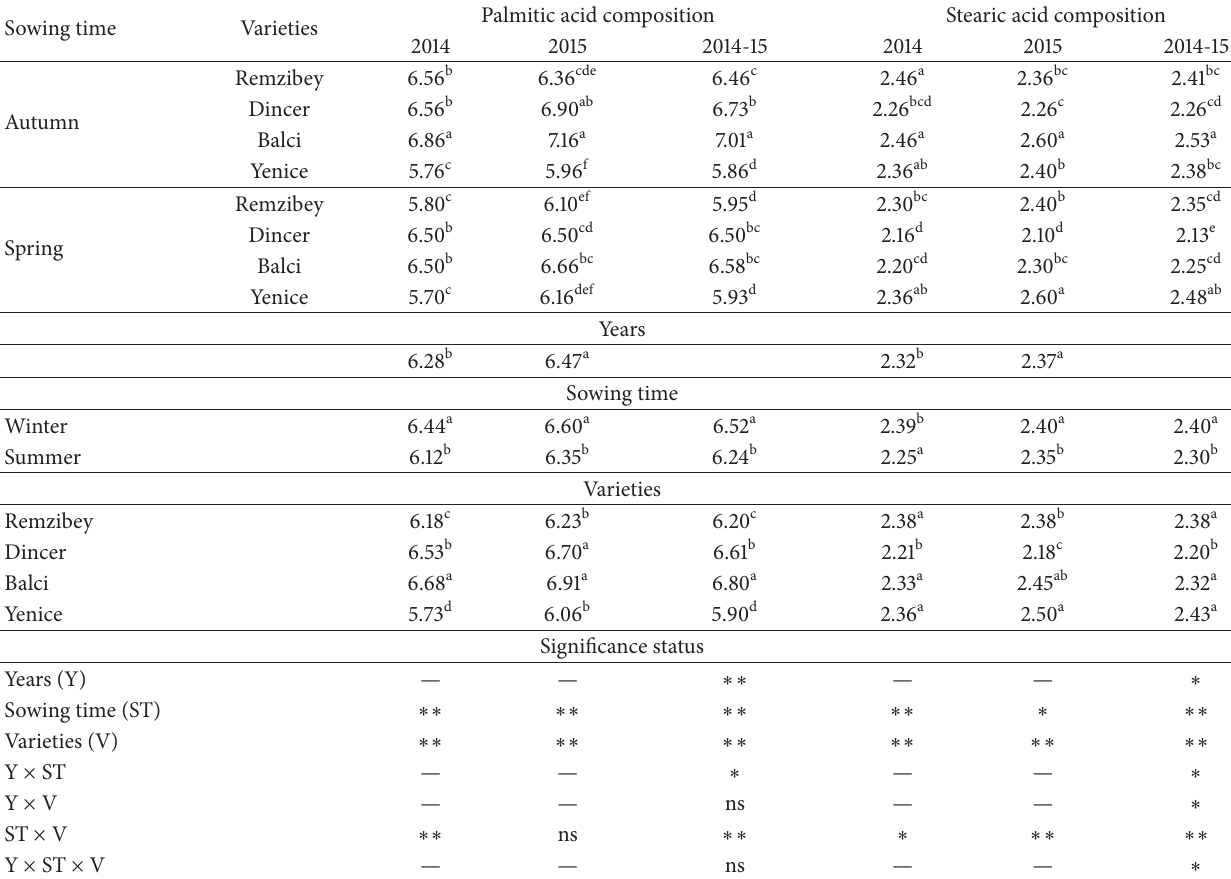
Table 2: Palmitic and stearic acid composition of safflower seeds sown in the autumn and spring. Sowing time